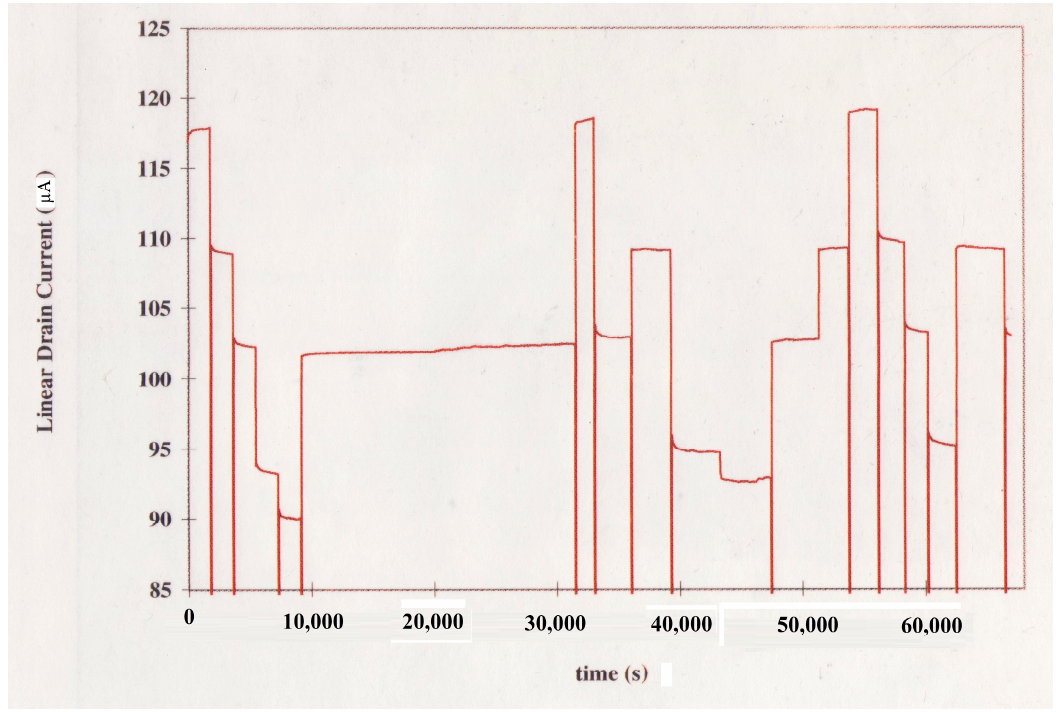
Figure 5. pH Response of the Si 3 N 4 -gate pH-sensitive ISFET.